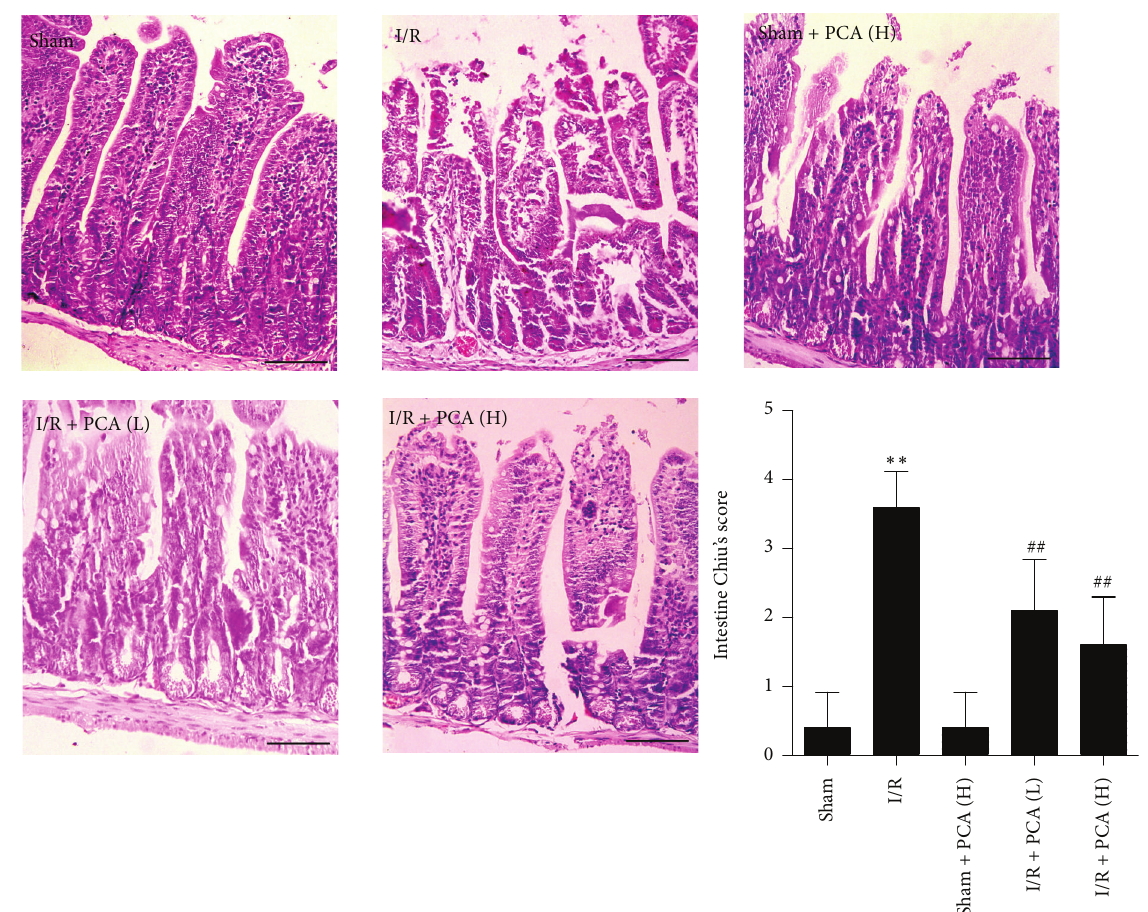
Figure1:PCApretreatmentimprovedintestinalI/R-inducedintestinehistopathologicinjury.Tissueswereharvestedattheendofreperfusion and were stained with hematoxylin eosin. Slides were examined under light microscopy at 200x magnification, bars = 50 𝜇 m. Histologic injury scores in groups were quantified. Results are presented as the mean ± SD, 𝑛 = 10 . ∗∗ 𝑃 < 0.01 versus sham group; ## 𝑃 < 0.01 versus I/R